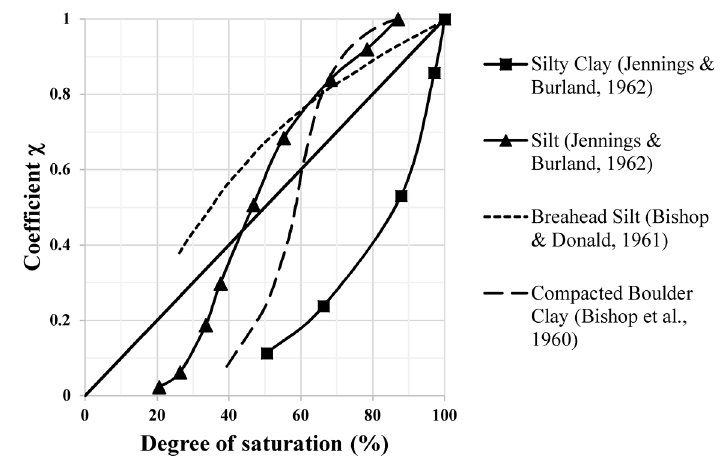
Figure 3. Relationship between the coefficient χ and the degree of saturation (Jennings and Burland [11]; Bishop and Donald [12]; Bishop et al. [13]).